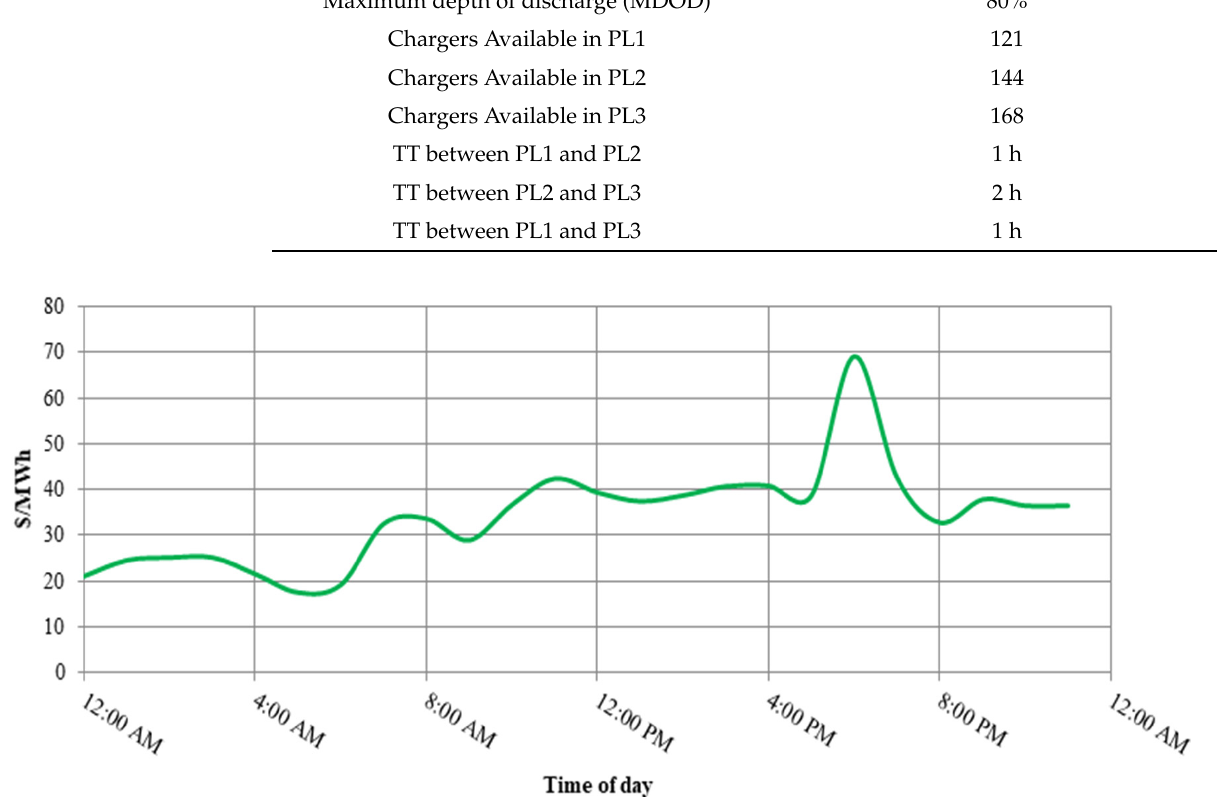
Figure 4. Grid price per hour for one day. Table 1. Model parameters.